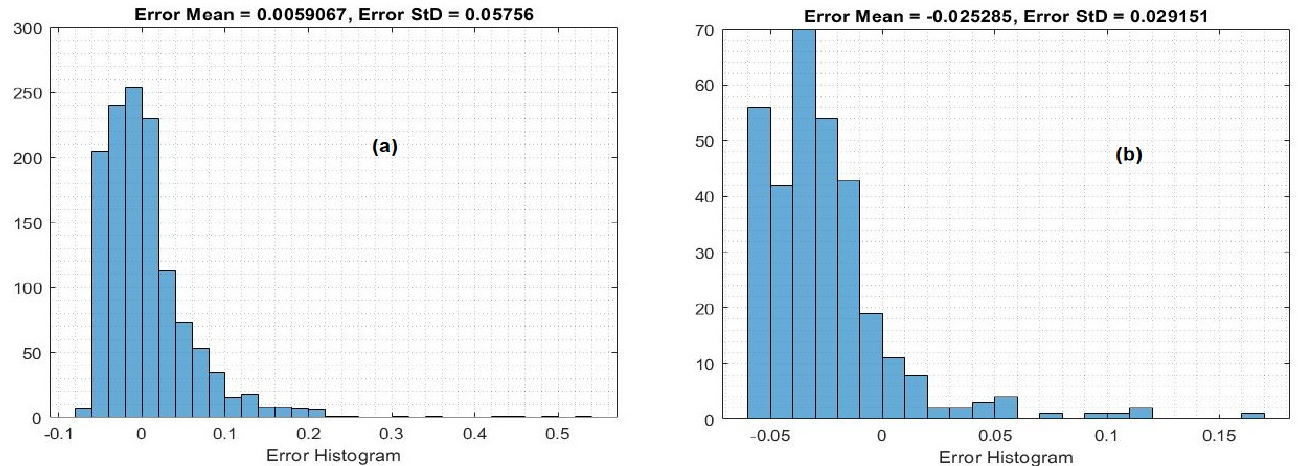
Figure 12. Error histograms of the LSTM model in predicting the prices of the EOS cryptocurrency in ( a ) training and ( b ) testing.